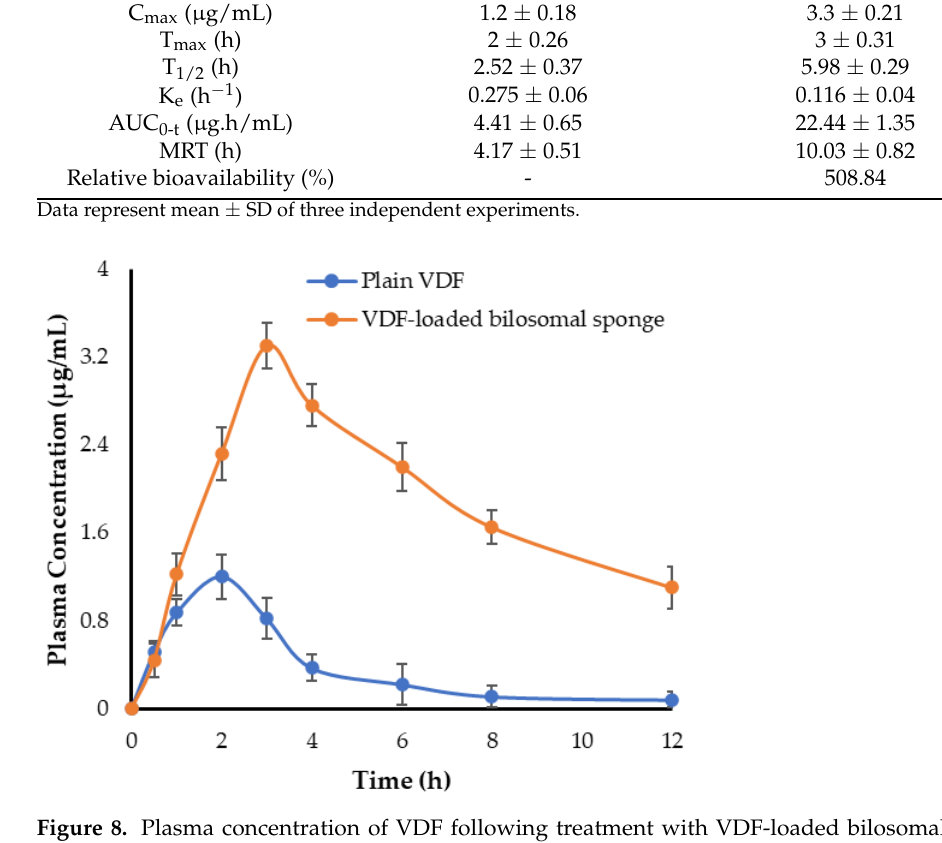
Figure 8. Plasma concentration of VDF following treatment with VDF-loaded bilosomal buccal sponge and VDF oral suspension. Data represented as mean ± SD. Table 4. Pharmacokinetic parameters of plain VDF (20 mg/kg, p.o.) and VDF-loaded bilosomal buc- cal formulation (20 mg VDF/kg).